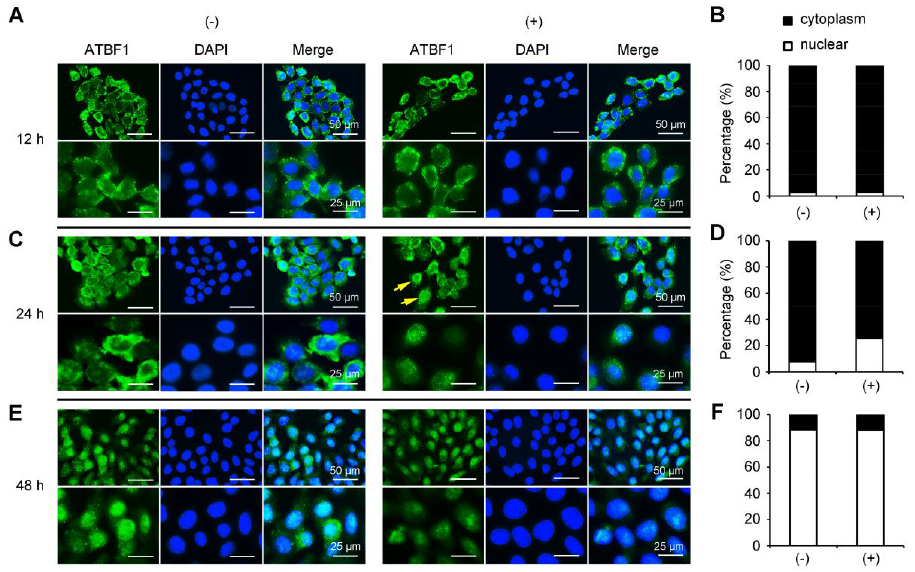
Figure 4. TGF- β promoted ATBF1 translocation from cytoplasm to nucleus. ( A , C , E ) IF staining for ATBF1 proteins (green) after TGF-β treatment for 12 (A), 24 (C), and 48 h (E). DAPI staining (blue) was used to show cell nucleus. ( B , D , F ) Cells with different localization of ATBF1 were counted from 10 random images in each group. ATBF1 was mainly localized in cytoplasm at 12 h (A,B) and in nucleus at 48 h (E,F) in both cells with (+) or without (−) TGF-β treatment. However, the cell ratio with nucleus localization of ATBF1 was higher in TGF-β group than that in the control group at 24 h (C,D).